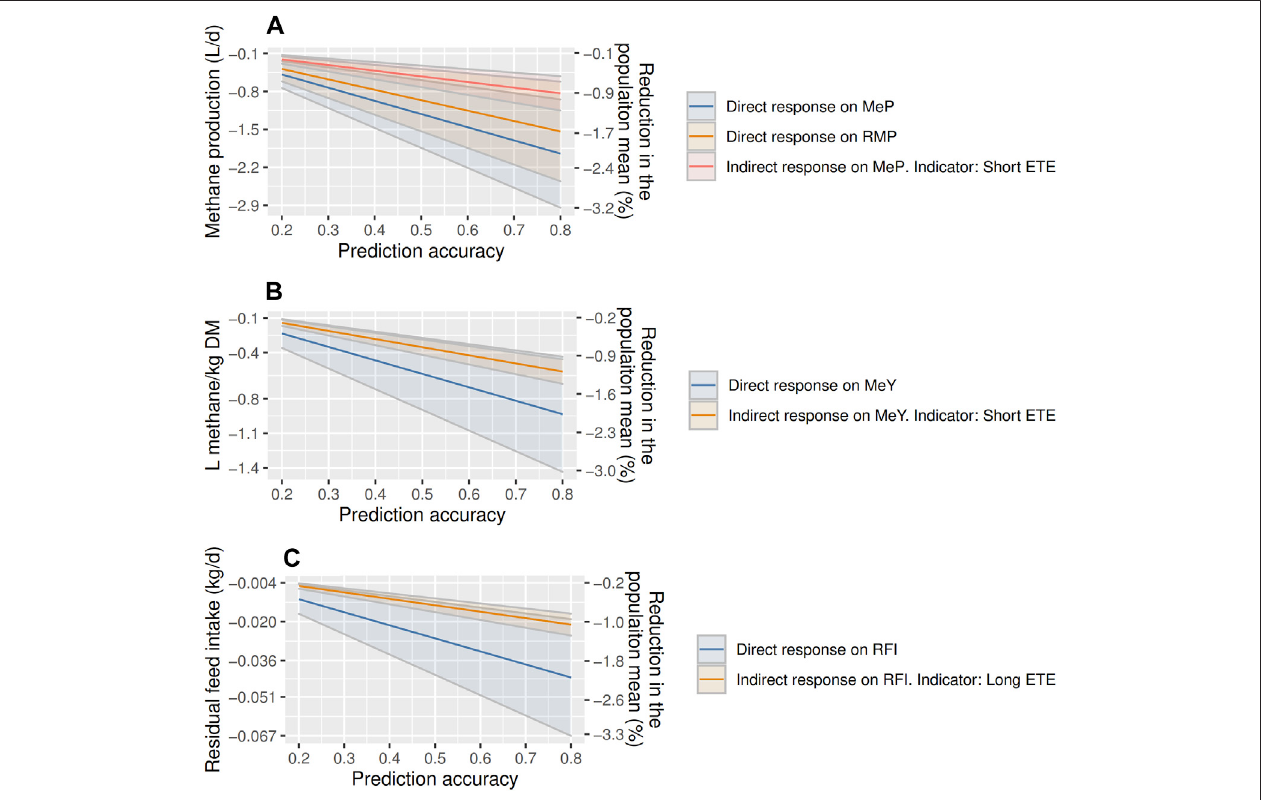
FIGURE 3 | Annual response to selection on methane production [MeP; (A) ], residual methane production [RMP; (A) ], methane yield [MeY = MeP/DMI; (B) ], and residual feed intake [RFI; (C) ] using direct selection, or indirect selection with eating time per eating event (ETE) as indicator trait in post-weaning, hogget, and adult Australian Maternal Composite ewes. Solid lines indicated the estimated responses to selection, and the highlighted areas are the standard